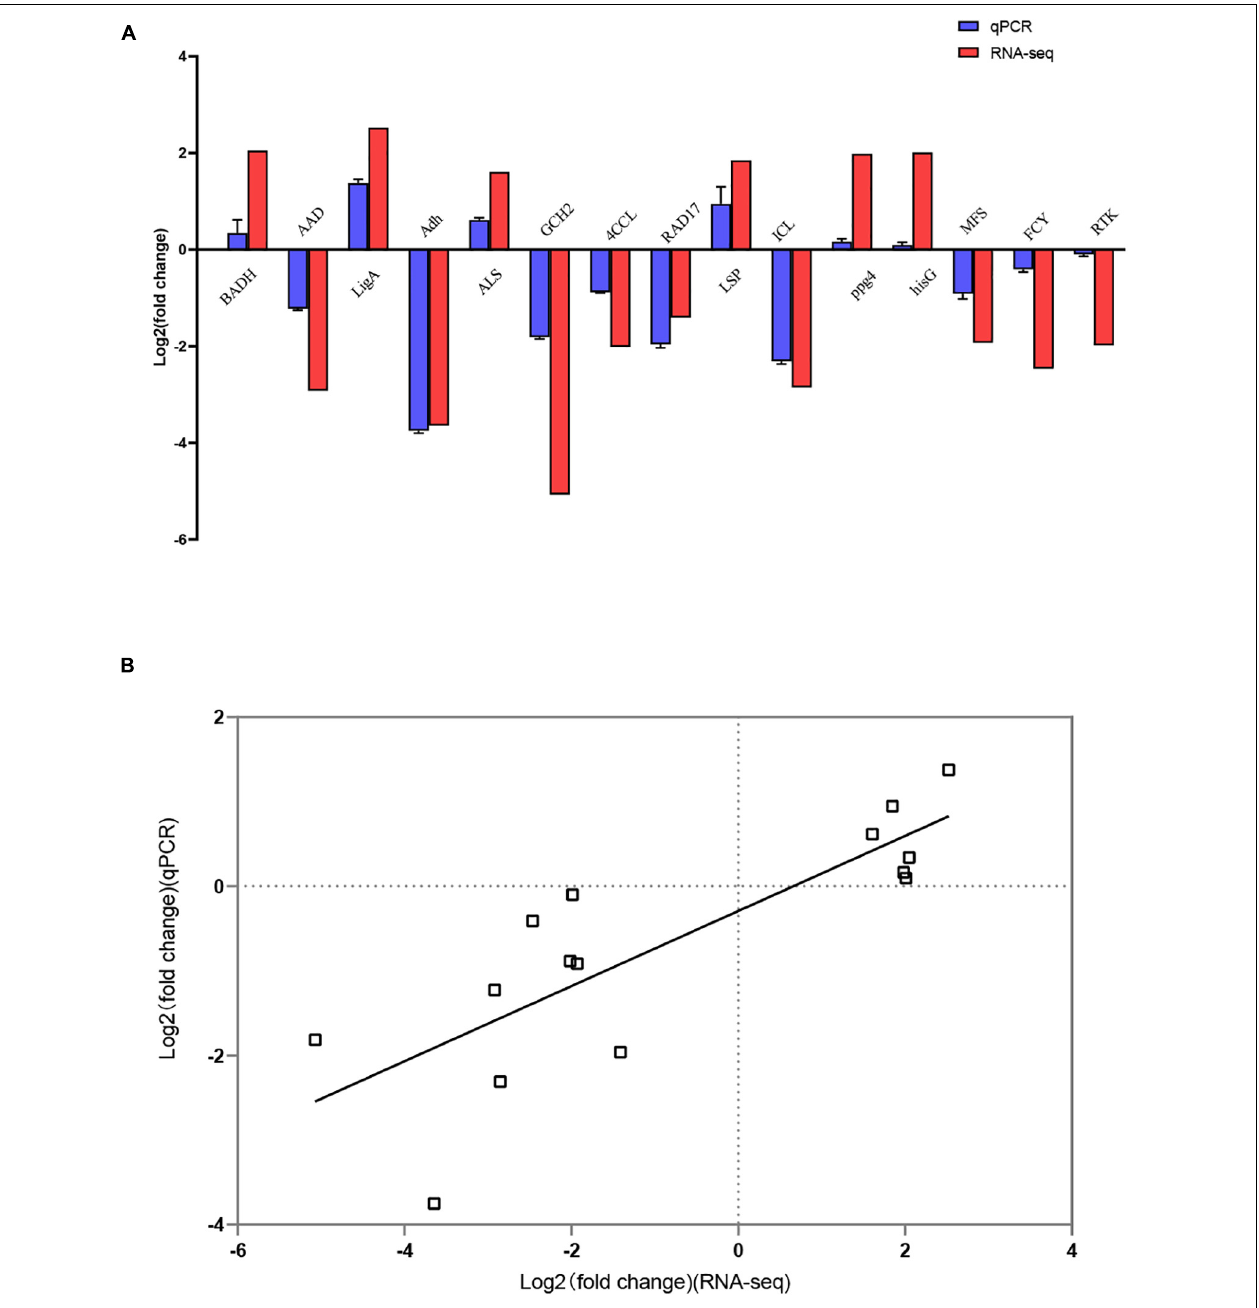
FIGURE 4 | Confirmation of RNA-seq results by quantitative real-time PCR (qPCR). (A) Comparison of the fold change in expression of 15 selected DEGs as detected using RNA-seq and qPCR. (B) Correlation of the fold change in the expression of 15 DEGs analyzed by RNA-seq and